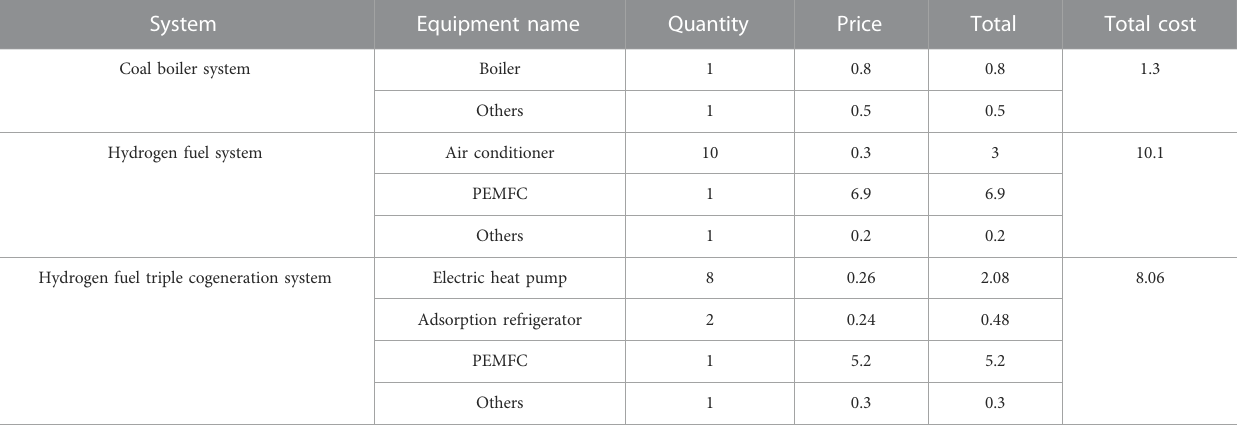
TABLE 2 Cost of the energy systems equipment (Unit: ten thousand dollars).